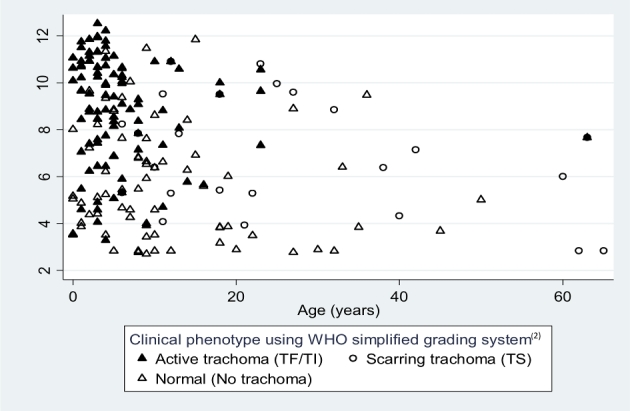

Chlamydia trachomatis load by age and clinical phenotype in infected individuals. The y axis shows the natural logarithmic scale of C. trachomatis bacterial load (omcB copies/swab).